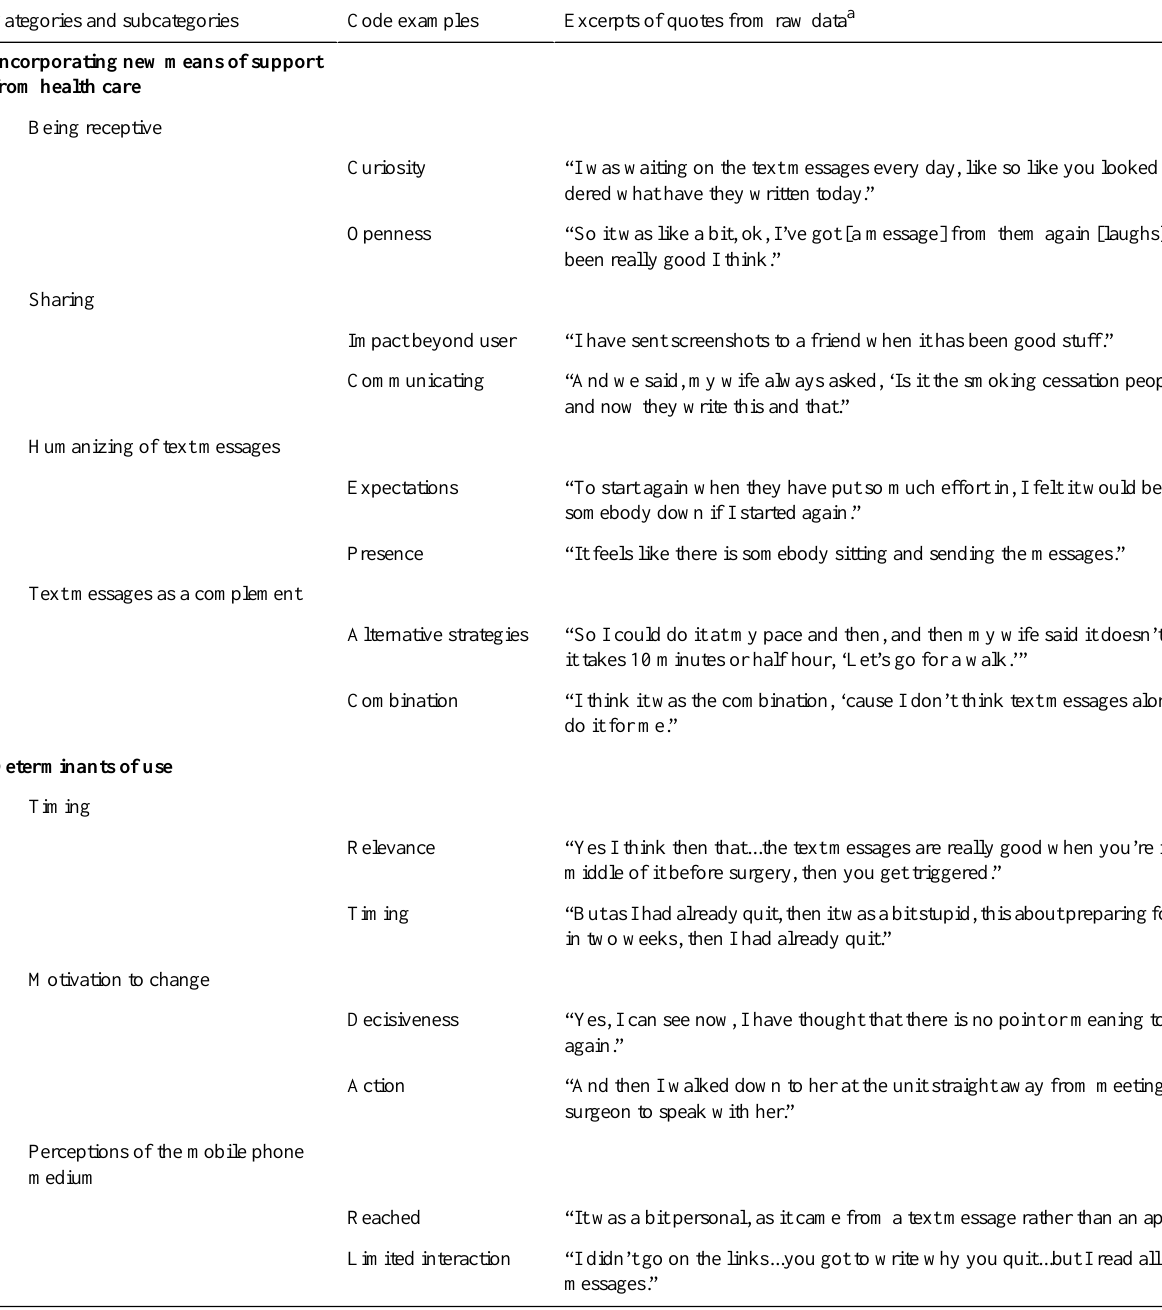
Excerpts of quotes from raw data a Code examplesCategories and subcategories